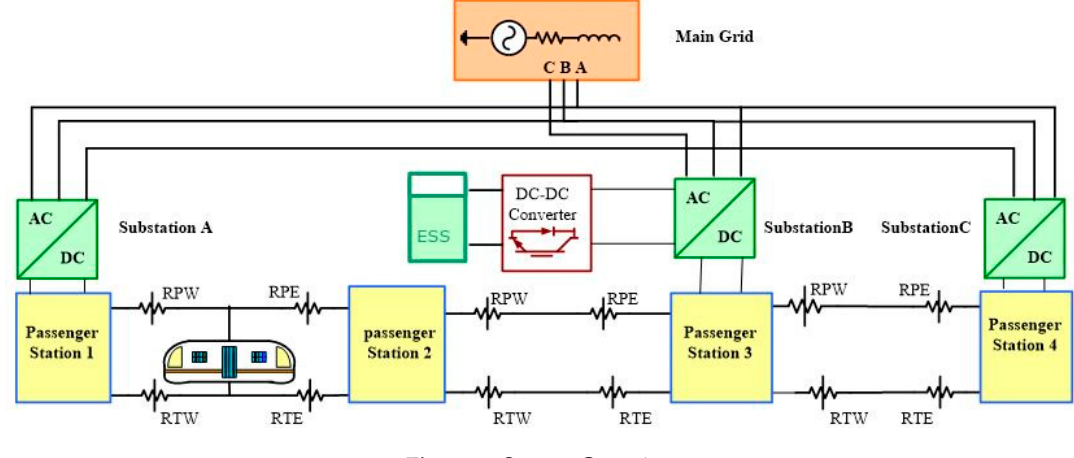
Figure 4. System Overview.